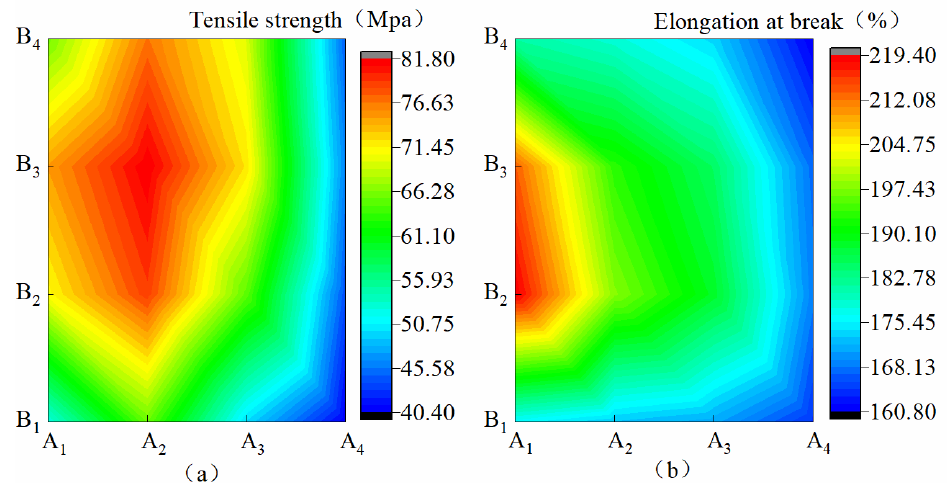
Figure 2. Mechanical properties of membrane materials under different ratios of water-based copol- ymer and zeolite amounts. ( a )Tensile strength, ( b ) Elongation at break.